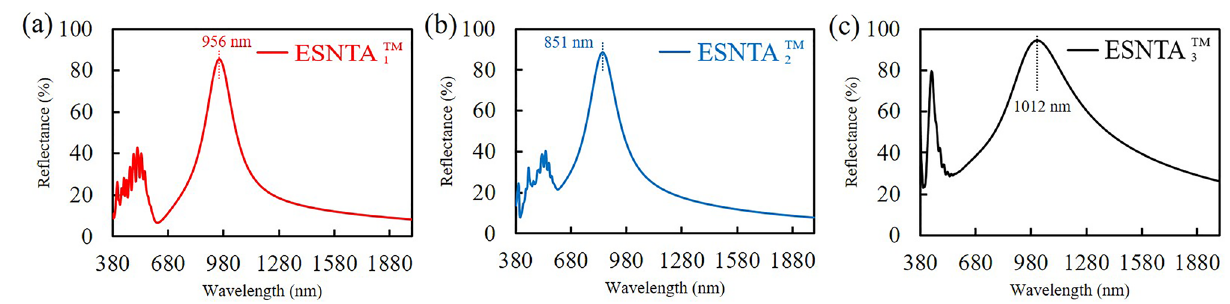
Figure 6. Simulated reflectance spectra of ( a ) ESNTA 1TM , ( b ) ESNTA 2TM , and ( c) ESNTA 3TM